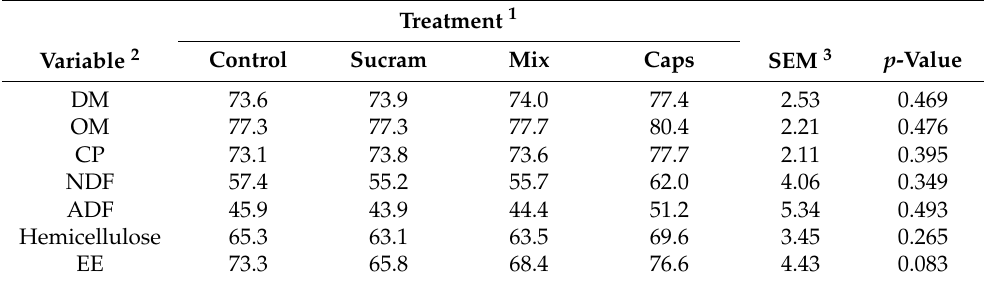
Table 3. Effect of the flavours on daily feed intake expressed in grams per metabolic body weight Table 4. Effect of flavours on the total tract feed digestibility in lambs (expressed in percentage). (g/Kg BW 0.75 ) in lambs.